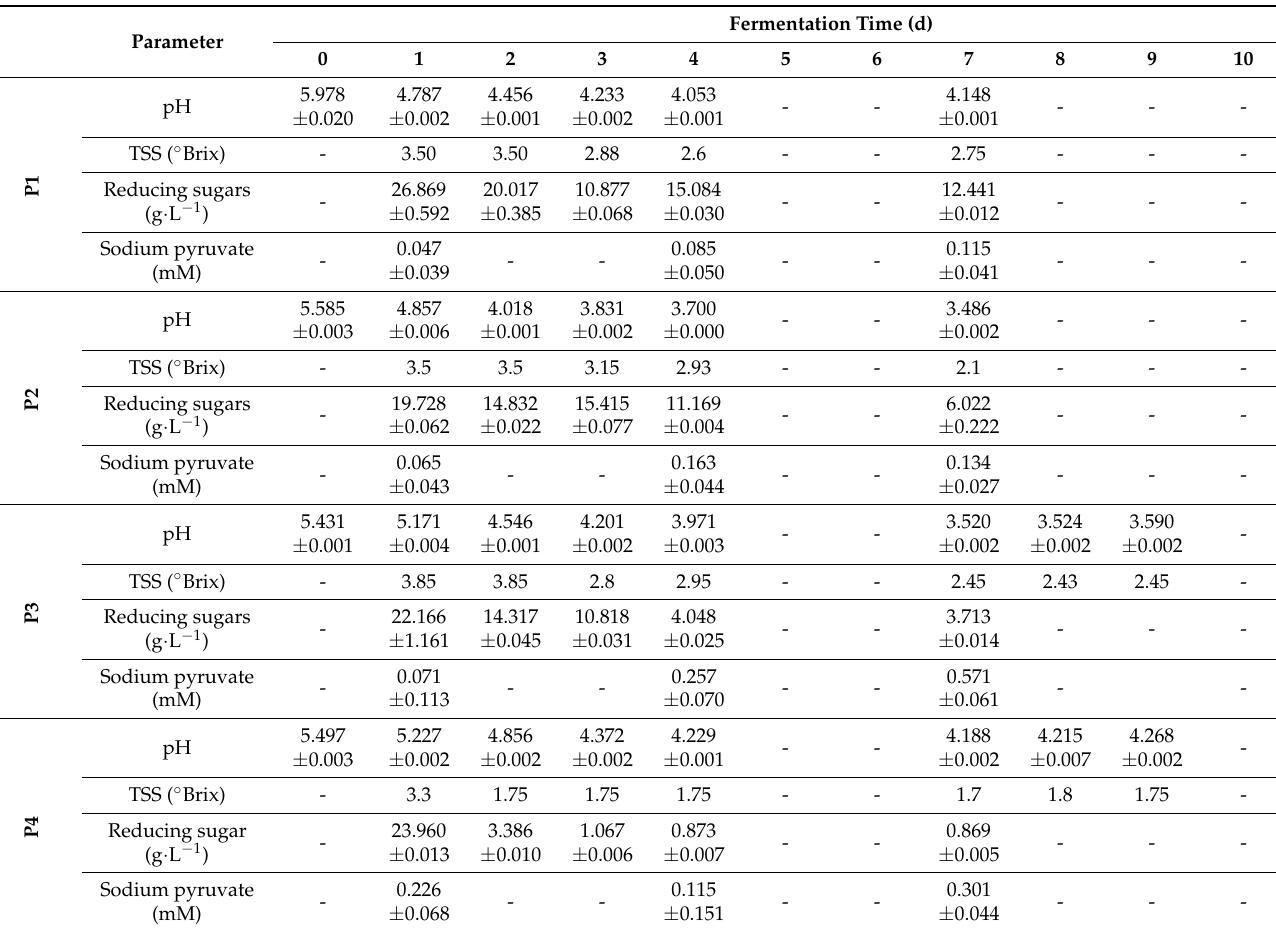
Table 2. Changes in pH, total soluble solid content (TSS), reducing sugar and sodium pyruvate concentrations during papaya fermentation assays (P1 to